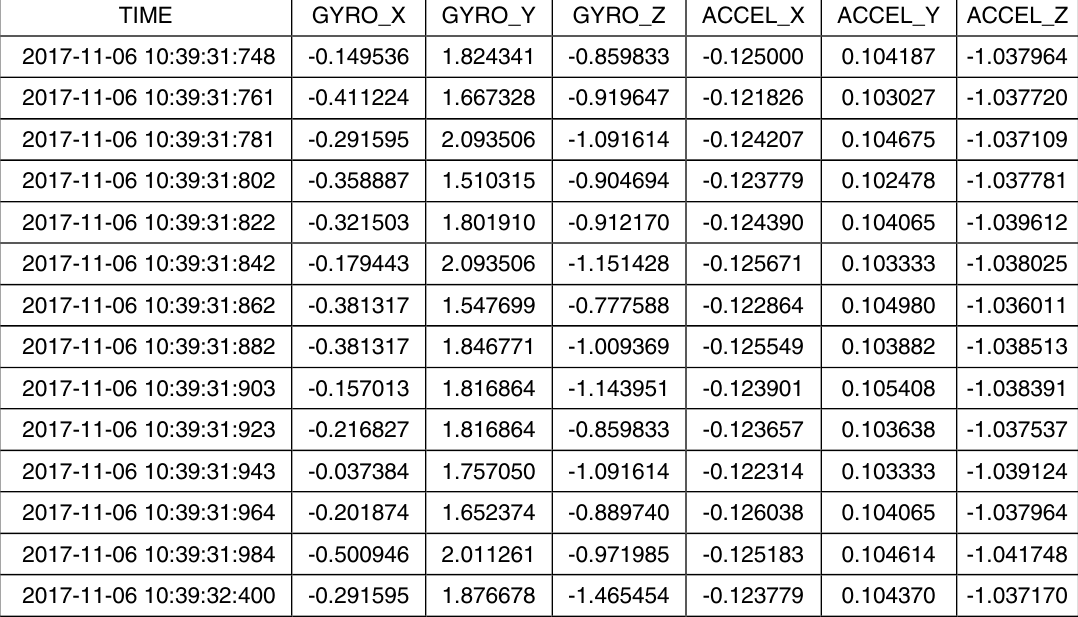
Figure 5. Example of the file including data registered during the experiments’